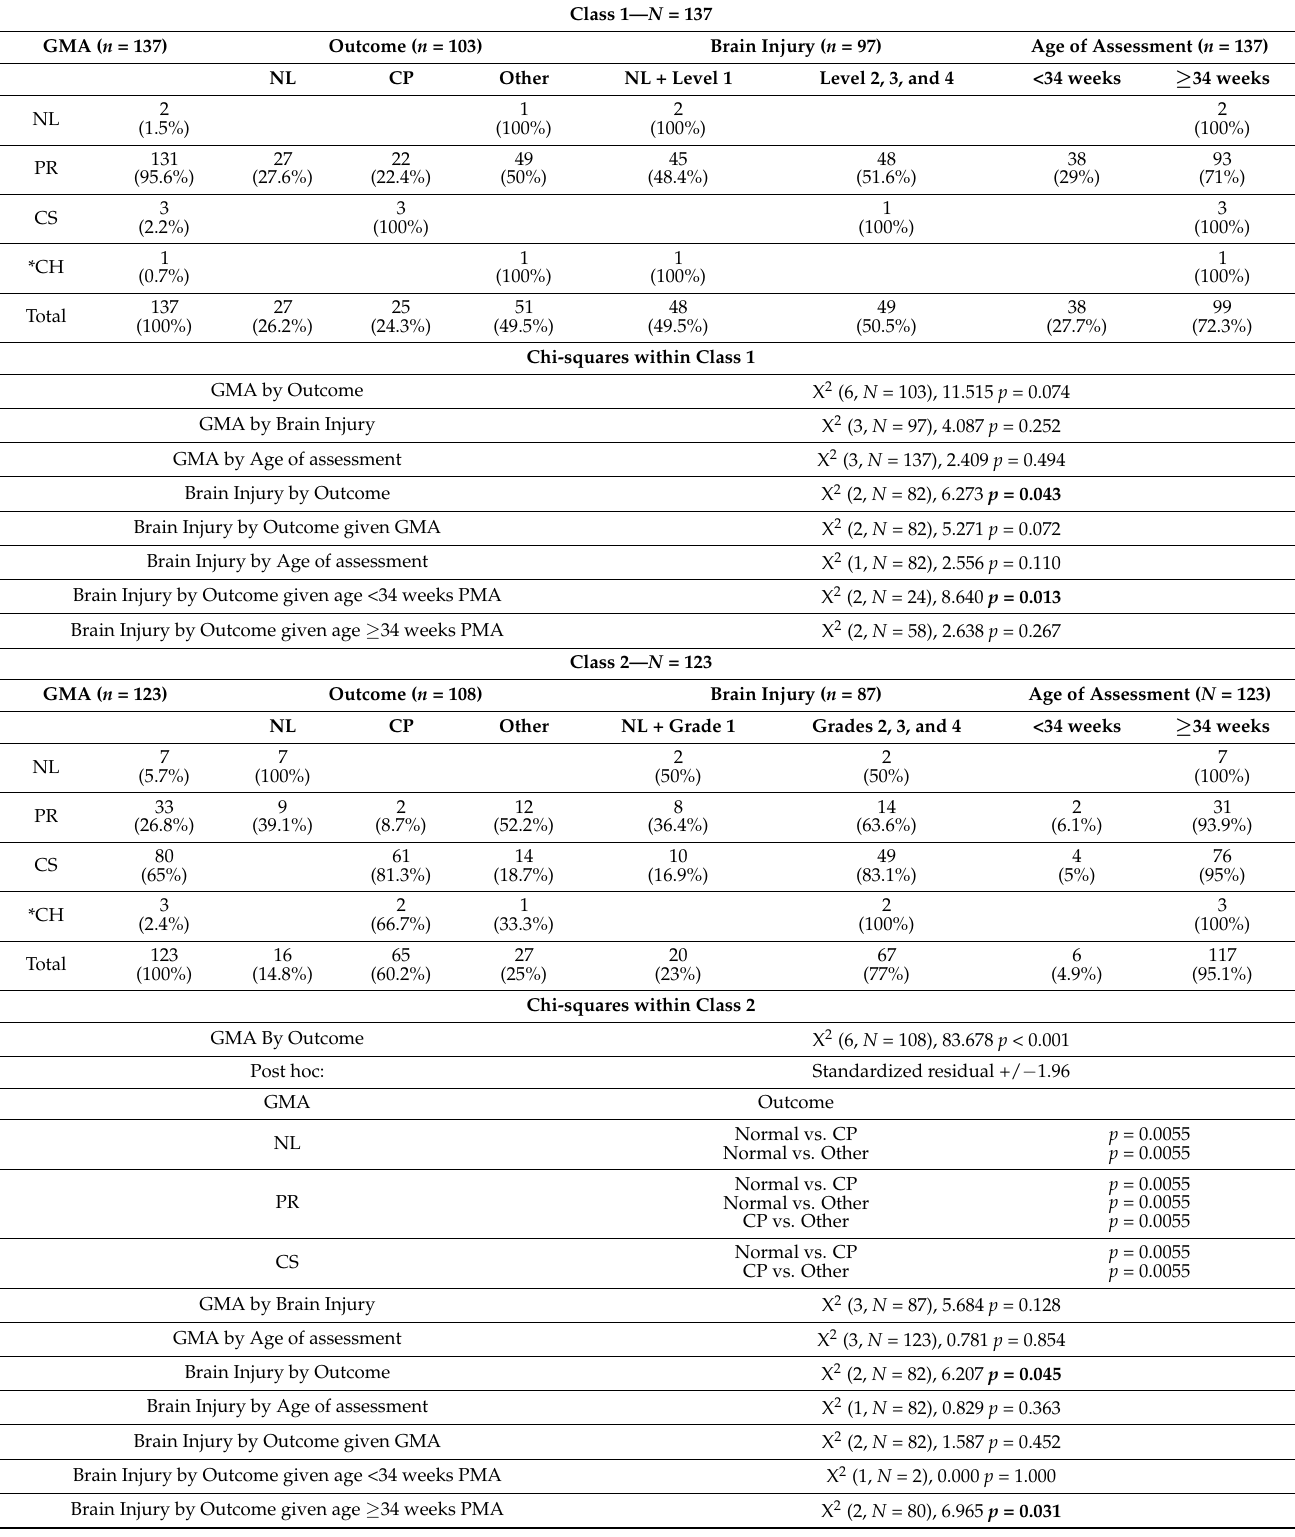
Table 3. Cross-tabulation and Chi-square examining the interaction between GMA, Outcome, Brain Injury, and age of assessment separately within class 1 and class